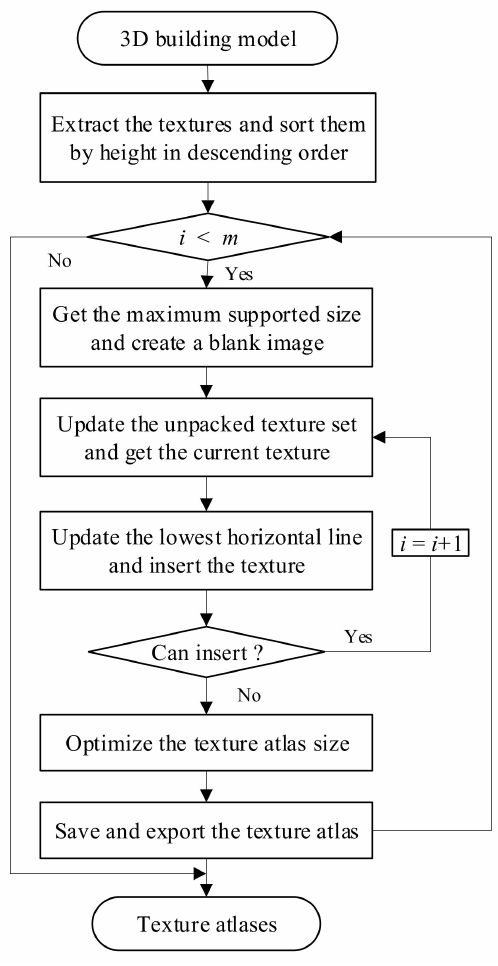
Figure 3. Multi-texture packing flow